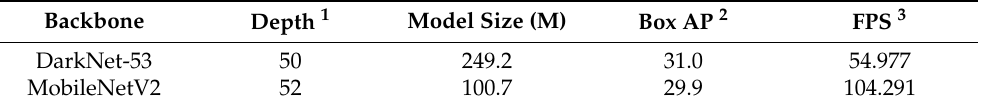
Table 1. DarkNet-53 vs.